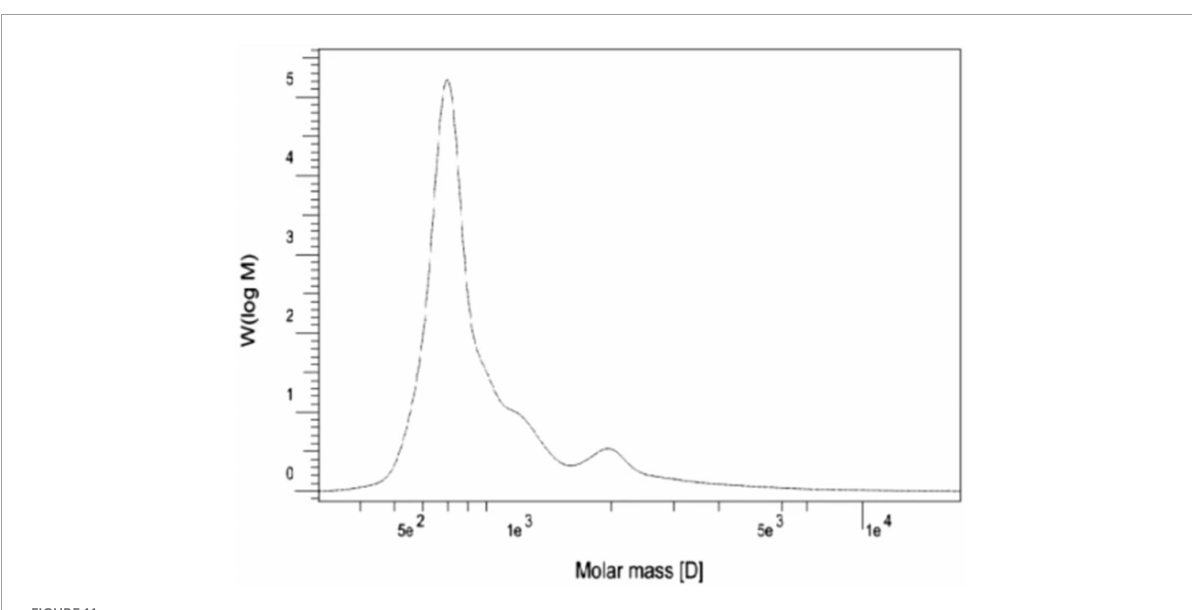
but not against K. pneumonia , S. aureus , or B. subtilis. Using the agar plug method, researchers have shown that the methanolic extract of latex from E. antiquorum reduces the growth of